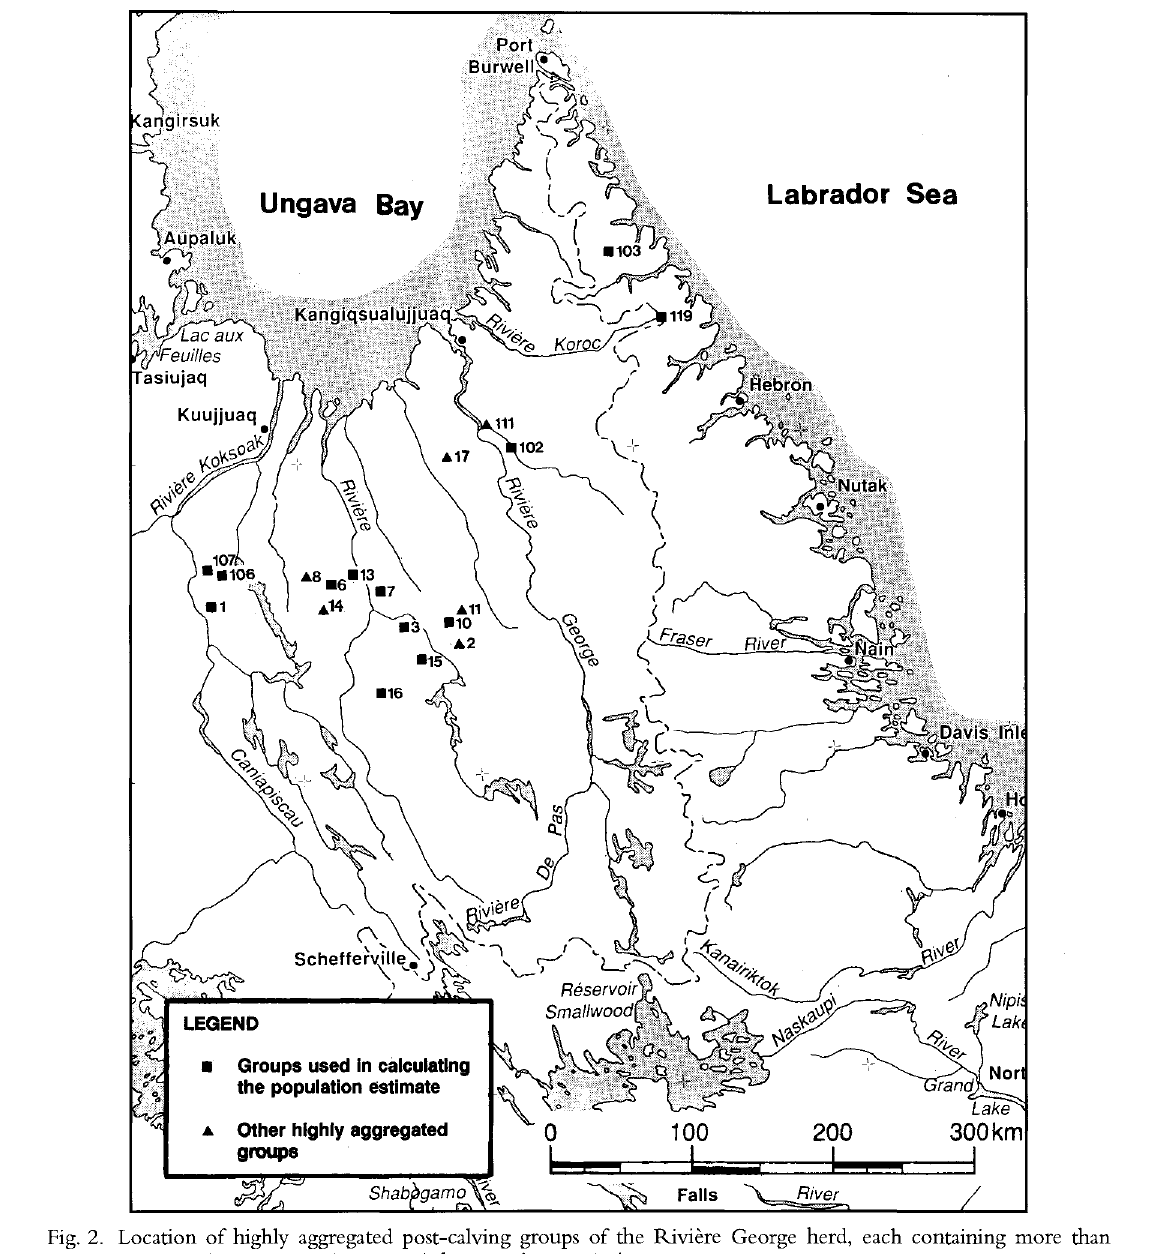
Fig. 2. Location of highly aggregated post-calving groups of the Rivière George herd, each containing more than 4 000 adult caribou, at the time of photography in July